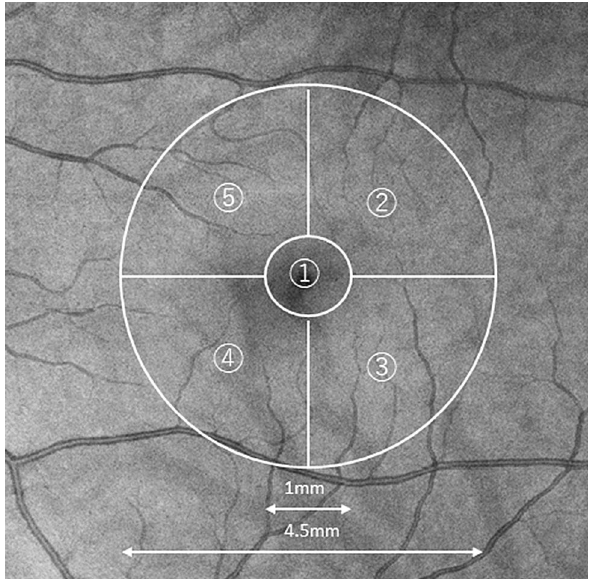
Figure 2. The analysis area is within a 4.5-mm circle centred on the fovea. The area is divided into five regions; ① , a circle with a 1-mm centre of the fovea and ② – ⑤ , outside the 4.5-mm circle except that the centre circle is divided by horizontal and vertical lines through the fovea. ② , upper temporal quadrant. ③ , Lower temporal quadrant. ④ Lower nasal quadrant. ⑤ Upper nasal quadrant.